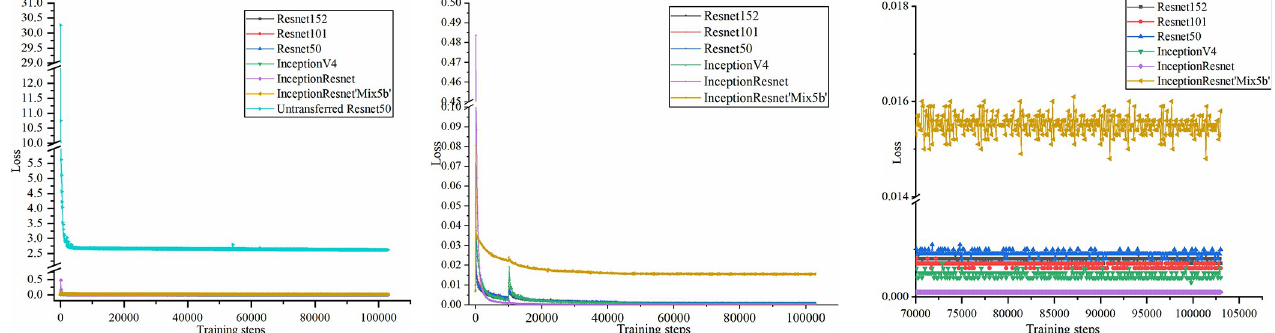
Fig 13. Loss function trend chart of different CNN backbones based on the encoding–decoding depth feature point extraction network. (a) Comparison of transfer learning and non-transfer learning. (b) Comparison of loss functions of different network backbones. (c) Final convergence of the network.